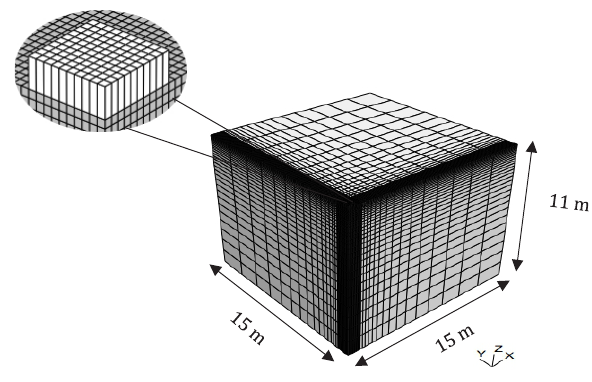
Figure 7: Three-dimensional mesh of the numerical model.